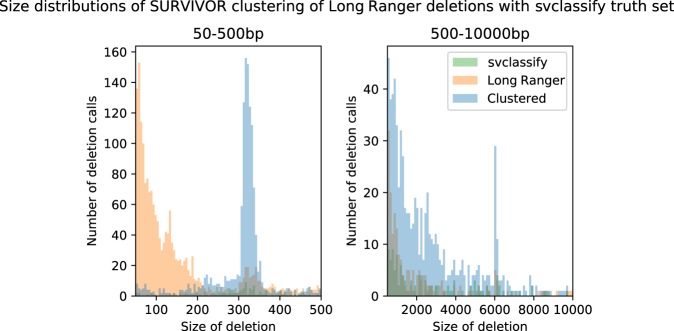
Deletion size distributions. Long Ranger calls intersected with the svclassify truth set by size. True positive calls are blue, false negative calls are green, and false positive calls are orange. Most false positives are present in the <250-bp size range, reflecting the lack of small deletions in the svclassify set. Peaks corresponding to Alu and L1/L2 elements can be seen at ∼320 bp and ∼6 kb, respectively.